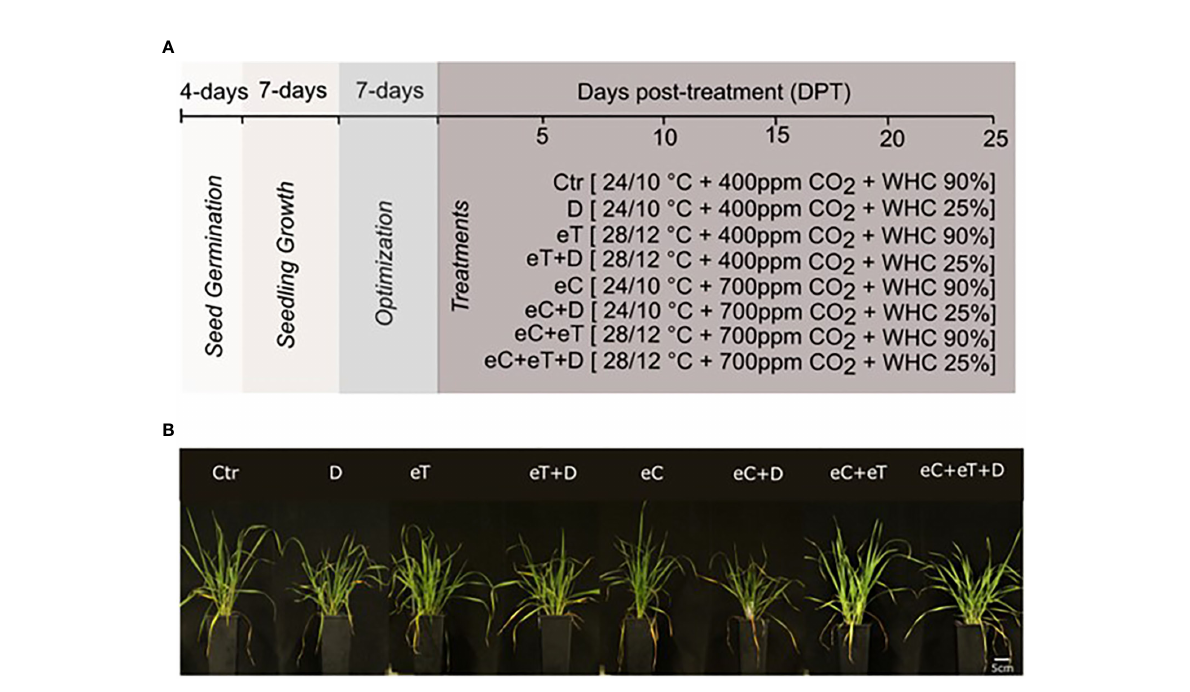
FIGURE 1 A schematic representation of experimental pipeline and developmental changes monitored in wheat cv. Cadenza. (A) Climate setup. Experimental setup to mimic the natural daily temperature dynamics (Tmax/Tmin) in June of years 2020 and 2100, atmospheric CO 2 concentration [ambient (400 ppm) and elevated (700 ppm)] and water availability [water holding capacity (WHC) at 25 ± 5% (Drought, D) and 90 ± 5% (water saturated pots)]. The symbol of ± indicates fl uctuations in the parameters. (B) Phenotypic differences observed at 25 DPT showing the variable effects of treatments. The bar scale represents 5 cm. Ctr, control treatment; eC, elevated CO 2 ; eT, elevated temperature; D, drought; eC+eT, elevated CO 2 and elevated temperature; eC+D, elevated CO 2 and drought; eT+D, elevated temperature and drought; eC+eT+D, elevated CO 2 , elevated temperature, and